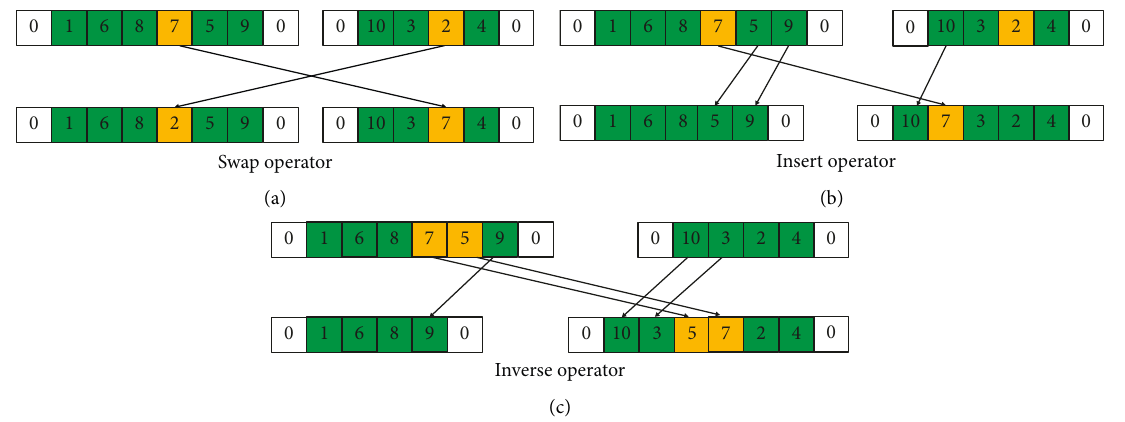
Figure 5: Intraroute search. (a) Swap operator. (b) Insert operator. (c) Inverse operator.